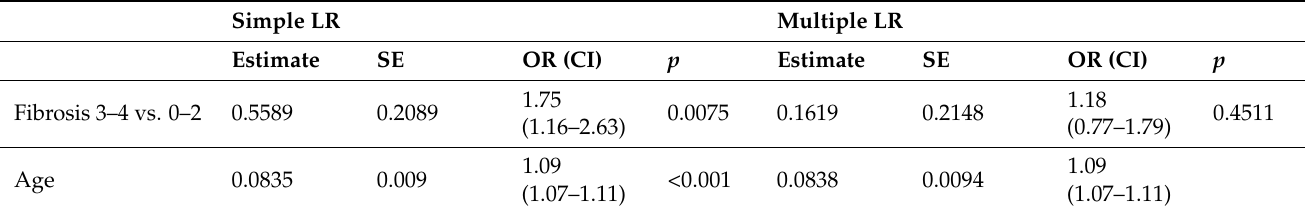
Table 5. Factors related to the incidence of cardiovascular diseases—logistic